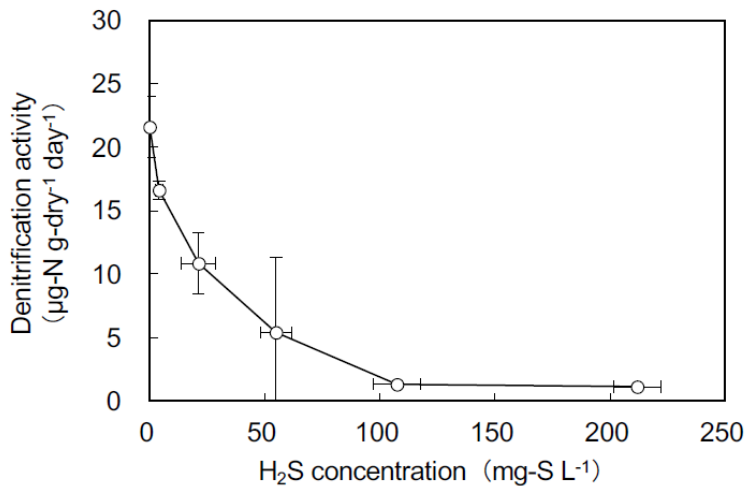
Table 2. Estimated, initial, and final sulfide concentrations (mg-S L − 1 ) to determine the effect of sul- fide on denitrification. The initial and final concentrations were measured on days 0 and 21, respec- tively.